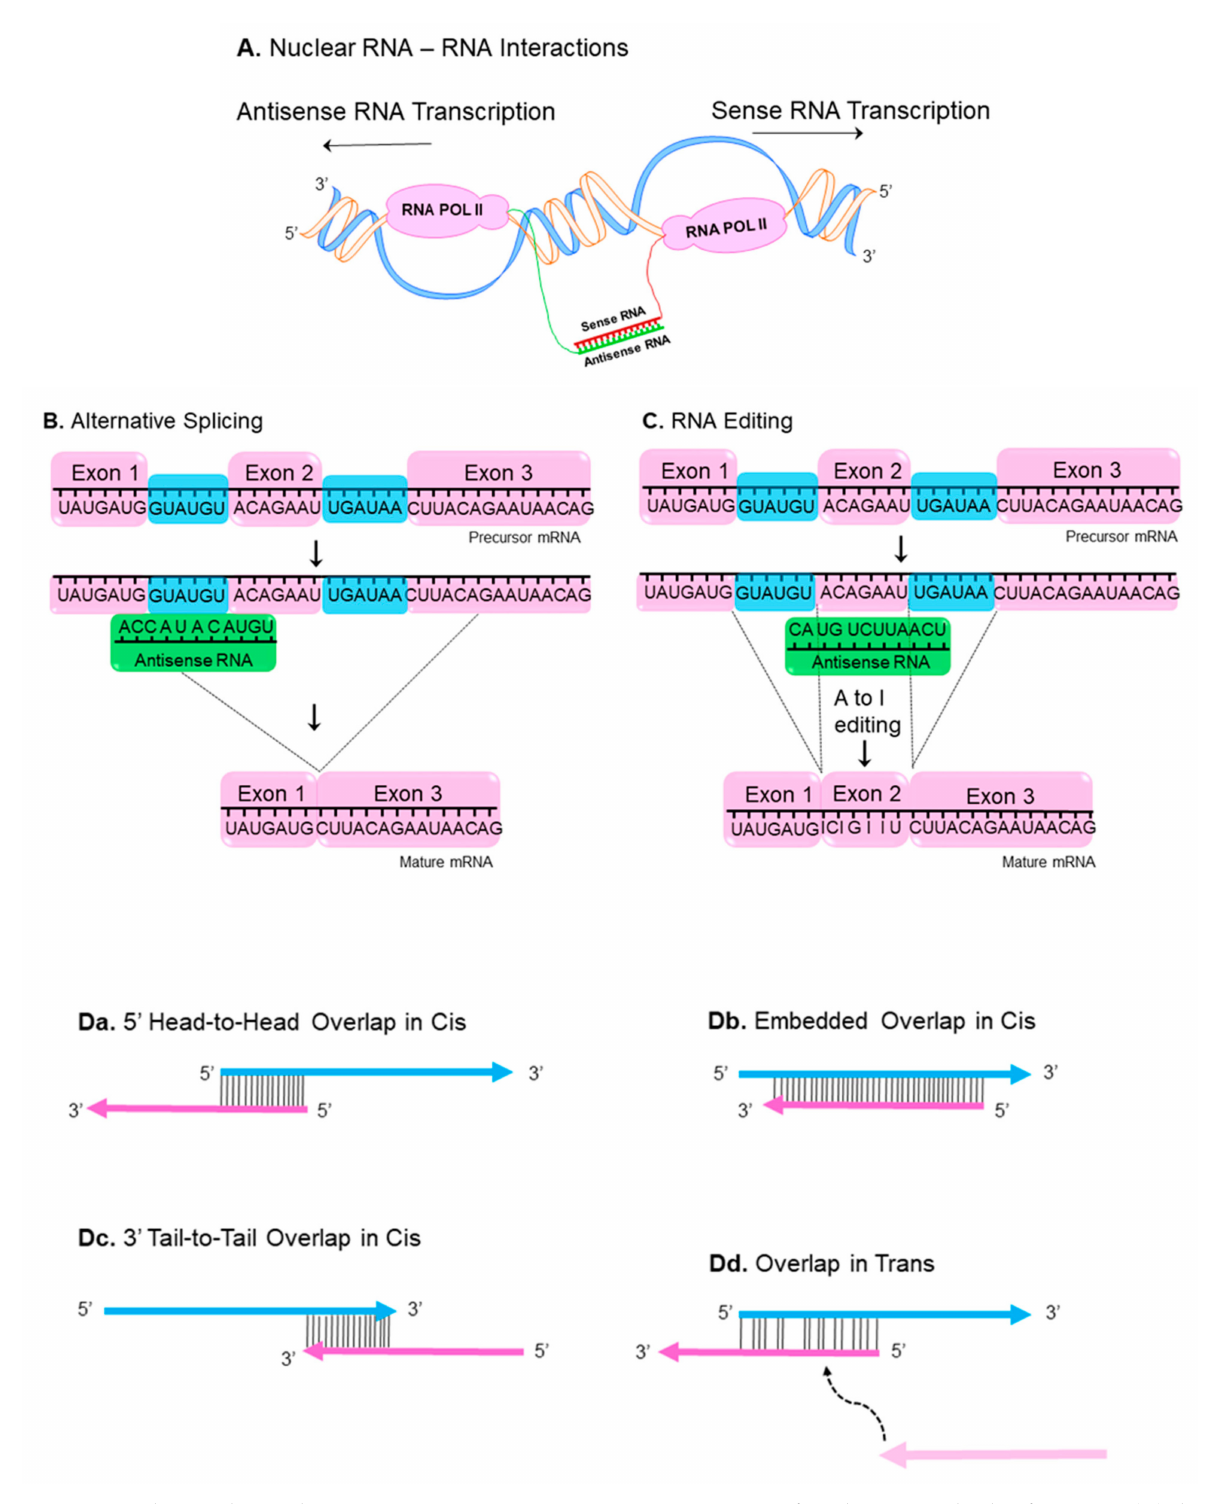
Figure 1. Nuclear and cytoplasmic sense–antisense RNA pairing. Diagram of nuclear RNA duplex formation ( A ) that further results in alternative splicing ( B ) or RNA editing ( C ). Classification of sense/antisense pairs ( D ). Sense genes represent in blue, whereas antisense transcripts are pink. The black lines between the genes indicates regions of overlap. There are different types of natural antisense transcripts overlapping: head-to-head overlap in cis ( Da ), embedded overlap in cis ( Db ), tail-to-tail overlap in cis ( Dc ), and overlap in trans ( Dd